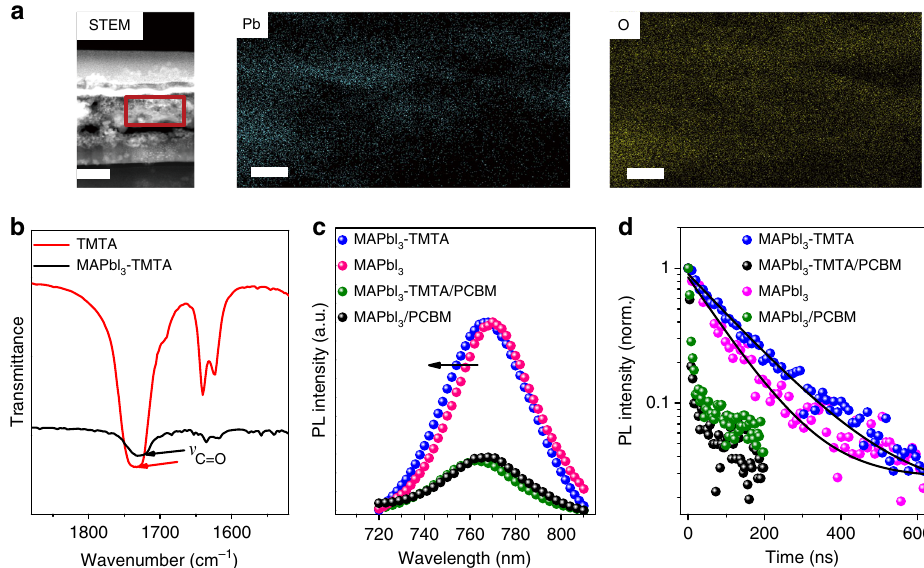
Fig. 3 TMTA distribution and photoluminescence (PL) characterization. a From left to right, scanning TEM (STEM, scale bar, 200 nm) image and EDS mapping of Pb and O (scale bar, 50 nm). The red line demarcates the EDS mapping area. b Enlarged FTIR spectra of MAPbI 3 – TMTA and pure TMTA; the arrows indicate the stretching vibration peak of C = O. c Steady-state PL spectra and d time-resolved PL decays of MAPbI 3 , MAPbI 3 /PCBM, MAPbI 3 – TMTA and MAPbI 3 – TMTA/PCBM. The arrow indicates the blue-shifted PL peak in MAPbI 3 – TMTA fi